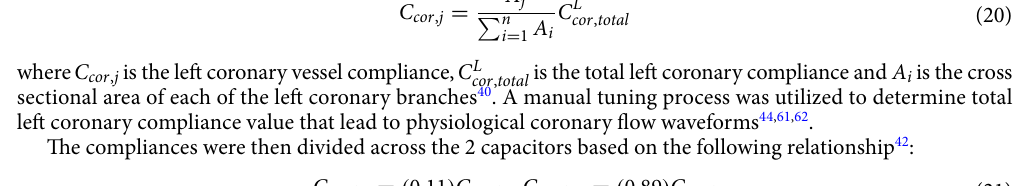
where C cor , j is the left coronary vessel compliance, C L cor , total is the total left coronary compliance and A i is the cross sectional area of each of the left coronary branches 40 . A manual tuning process was utilized to determine total left coronary compliance value that lead to physiological coronary flow waveforms 44,61,62 .